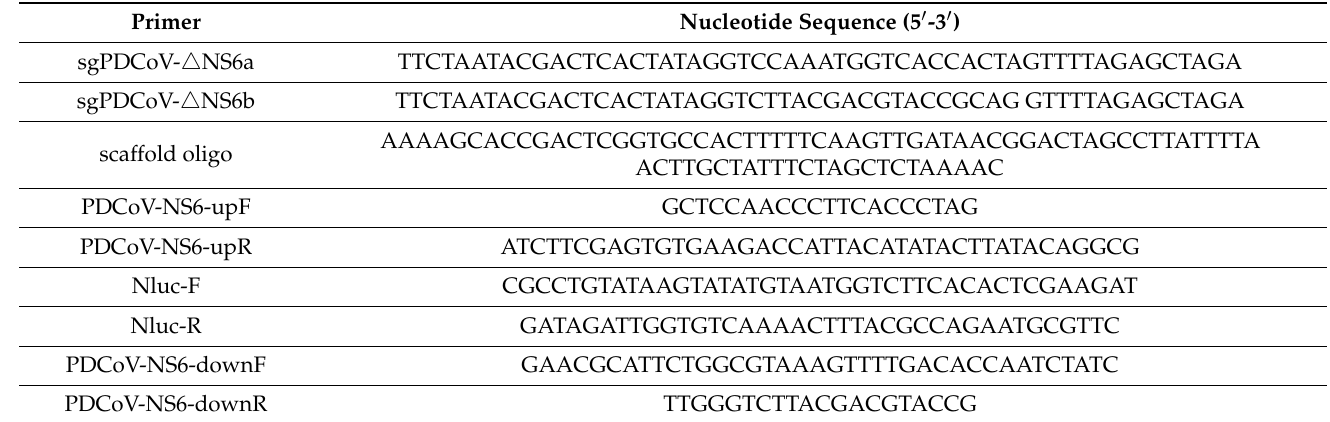
Table 2. Primers used for the construction of recombinant plasmid pBAC-CHN-HN-2014 containing Nluc gene.